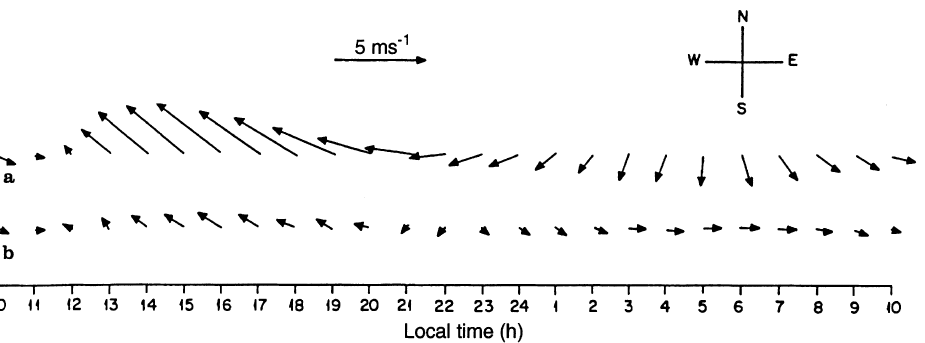
Fig. 15a,b. The same as Fig. 14, except for a non upwelling case. The simulations and observations correspond